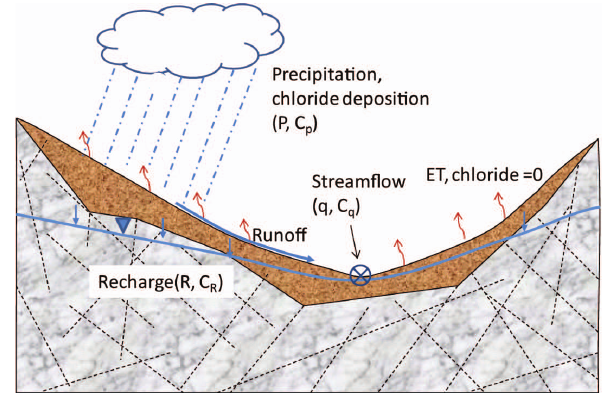
Fig. 1. A conceptual mountainous catchment showing hydrological processes involved in catchment chloride mass balance (modified from Dettinger 1989), where P is precipitation, C p is bulk chlo- ride concentration, ET is evapotranspiration, R is net water-table recharge (net water vertically added to the groundwater table from vadose zone), C R is the mean recharge groundwater chloride con- centration, q is streamflow at the catchment outlet point, and C q is the streamflow mean chloride concentration. The upper zone of the cross section represents shallow colluvial type deposits, and while the lower zone represents fracture rock. Fig. 2. Conceptualisation of catchment chloride balance under var-